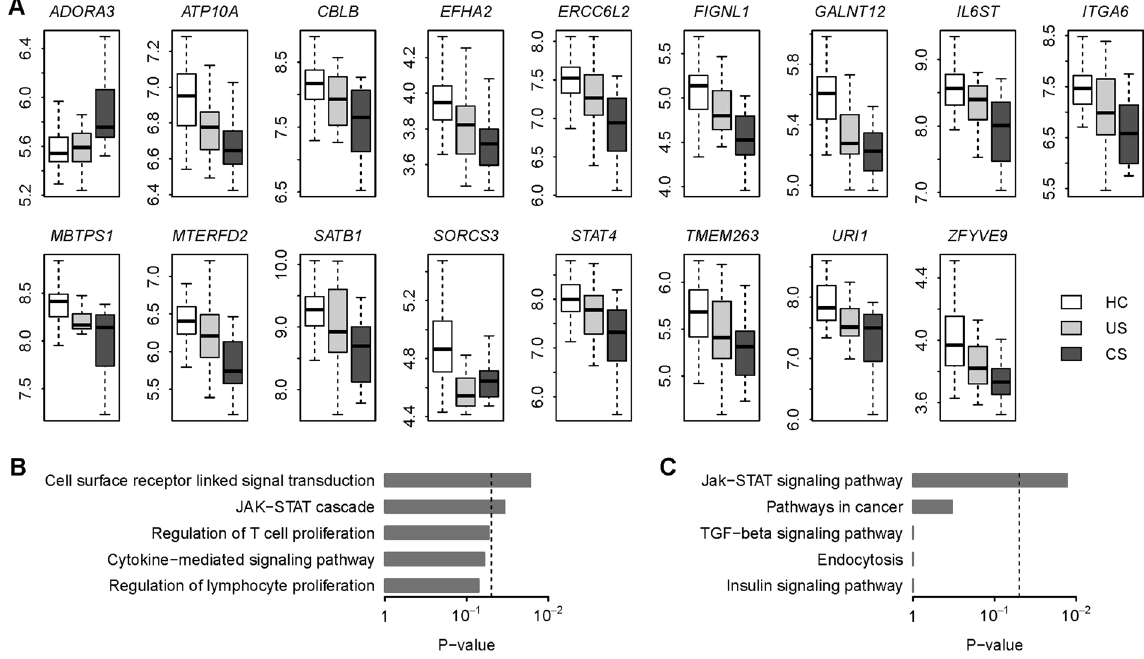
Figure 2. 17-gene signature in sarcoidosis. ( A ) The 17 protein-coding genes were differentially expressed with the severity of sarcoidosis. Y-axis indicates the gene expression level. HC: healthy controls; US: uncomplicated sarcoidosis; CS: complicated sarcoidosis. ( B ) The top five GO biological process terms associated with the 17- gene signature. The P -values were calculated by Fisher’s exact test. The dash line denotes the significance level of 0.05. ( C ) The top five KEGG pathway terms associated with the 17-gene signature. The P -values were calculated by Fisher’s exact test. The dash line denotes the significance level of 0.05.